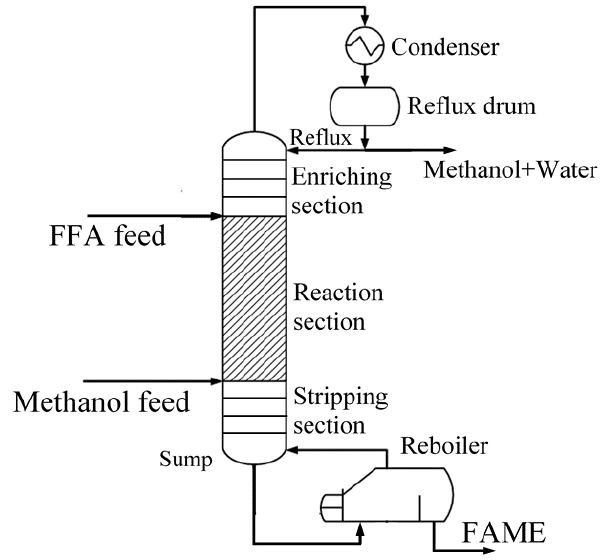
Figure 2. Process flowsheet for the production of high purity biodiesel.